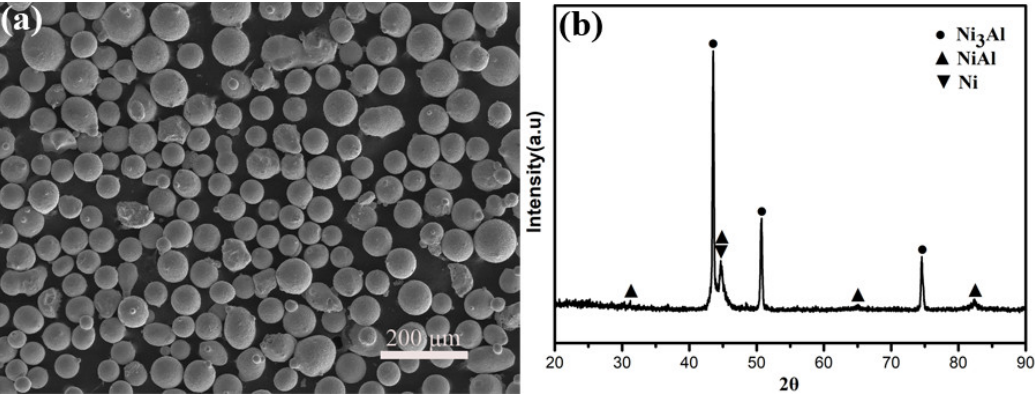
Figure 2. SEM micromorphology ( a ) and XRD pattern ( b ) of NiCrAlY powder.